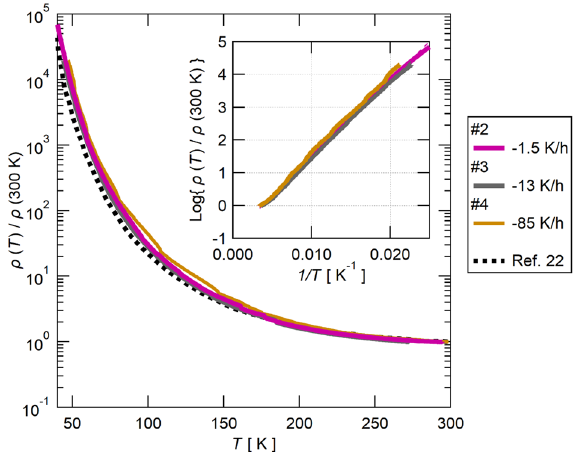
Figure 1. The temperature dependence of the resistivity of Sample #2, #3, and #4 normalized by the value at room temperature. The data of Ref. 22 is shown for reference (the dashed line). The inset shows the Arrhenius plot of the data, showing that the temperature dependence of the resistivity follows the simple activated behavior ( ρ ∝ exp (�/ k B T )